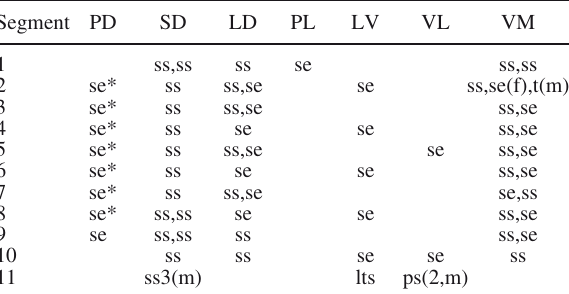
10. Dorsal side with short secondary pectinate fringes in the anterior part of the segment, present from the tergosternal junction to the laterodorsal longitudinal ridge (Fig. 3K). Sternal plates with one pair of ven- tromedial sensory spots. Males always with a pair of large tubes located in the ventromedial position (Fig. 2A) and females with a pair of ventromedial setae (Fig. 2C). Ventral side with secondary pectinate fringe similar to that on the dorsal side, from the ter- gosternal junction to the first ventromedial cuticular ridge. Cuticular wrinkles located in the anteriormost parts of the sternal plates, from the tergosternal junc- tion to the cuticular ridge, anterior to secondary pec- tinate fringe (Fig. 2A). Hairy tergosternal junctions, with numerous short cuticular hairs present (Fig. 3K). Pectinate fringe on both dorsal and ventral sides most developed near the lateral margins (Fig. 3K). Glan- dular cell outlets present anterolaterally on tergal and sternal plates, anterior to the secondary pectinate fringes. Pachycycli of tergal and sternal plates well developed, with a regular size of peg and socket joints. Segment 3: Tergal plate with a single paradorsal seta but without middorsal structures (middorsal pro- cesses or elevations) or intracuticular atria, one pair of laterodorsal setae, and one pair of subdorsal and lat- erodorsal sensory spots (Figs 3B-C, 4B). Laterodorsal sensory spots more lateral than laterodorsal setae (Fig. 3F). Lateroventral setae not present. Sternal plates with one pair of ventromedial setae and slightly more lateral sensory spots (Fig. 3A). Tergosternal junctions, pachy- cycli, peg and socket joints, muscular scars, glandular cell outlets, cuticular wrinkles, pectinate fringe and sec- ondary pectinate fringes as on the preceding segment. Segment 4: Tergal plate with a single paradorsal seta but without middorsal structures (middorsal pro- cesses or elevations) or intracuticular atria (Figs 2B, 4B). Additional setae include one pair in laterodorsal and in lateroventral positions. Paired sensory spots present in subdorsal positions (Figs 3B-C, 4B). Sternal plates same as on segment 3 (Figs 3A), and segment otherwise similar to segment 2.